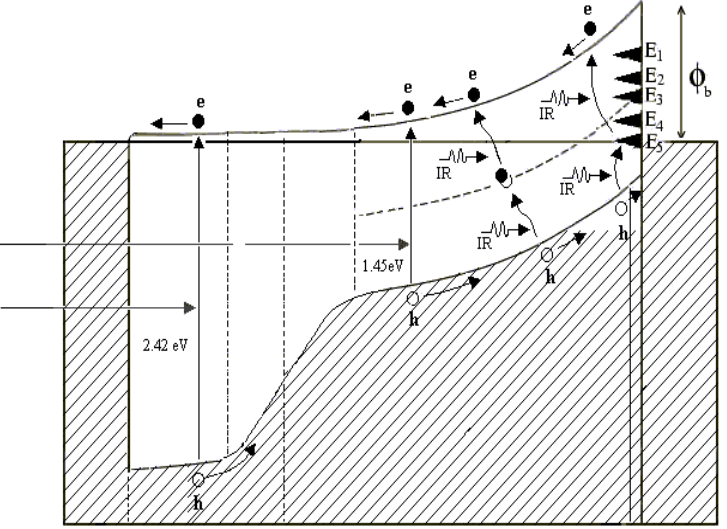
Figure 23. The formation of an n-n hetero-junction and a large Schottky barrier at the CdTe/metal interface, when CdTe is grown with n-type electrical conduction. The p-type dopant containing Au, Cu/Au, Cu/Ni, Sb and As-containing compounds form a large Schottky barrier of ~1.20 eV ( E − E ~ 1.20 eV) by pinning the FL at E level in n-CdTe layer c 5 5